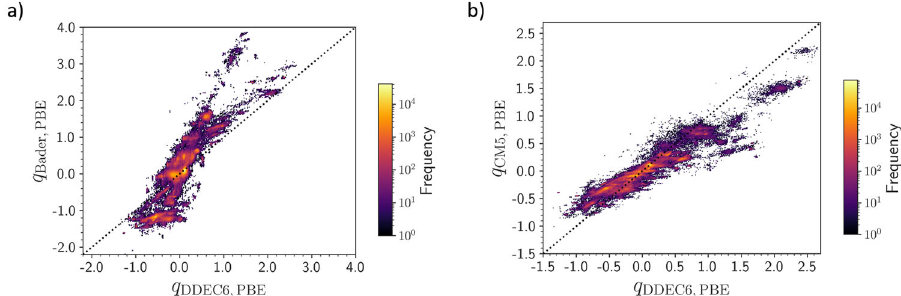
Fig. 5 Correlation between partial atomic charges with different charge partitioning schemes. a Comparison of the partial atomic charges, q , for 1,429,082 atoms computed using the Bader and DDEC6 charge partitioning schemes at the PBE level of theory. b Comparison of the partial atomic charges, q , for 2,321,435 atoms computed using the CM5 and DDEC6 charge partitioning schemes at the PBE level of theory. Given the large dataset size, the data is shown as 2D histograms with the logarithmic color bar re fl ecting the frequency of points in each bin. The y = x line is shown as for